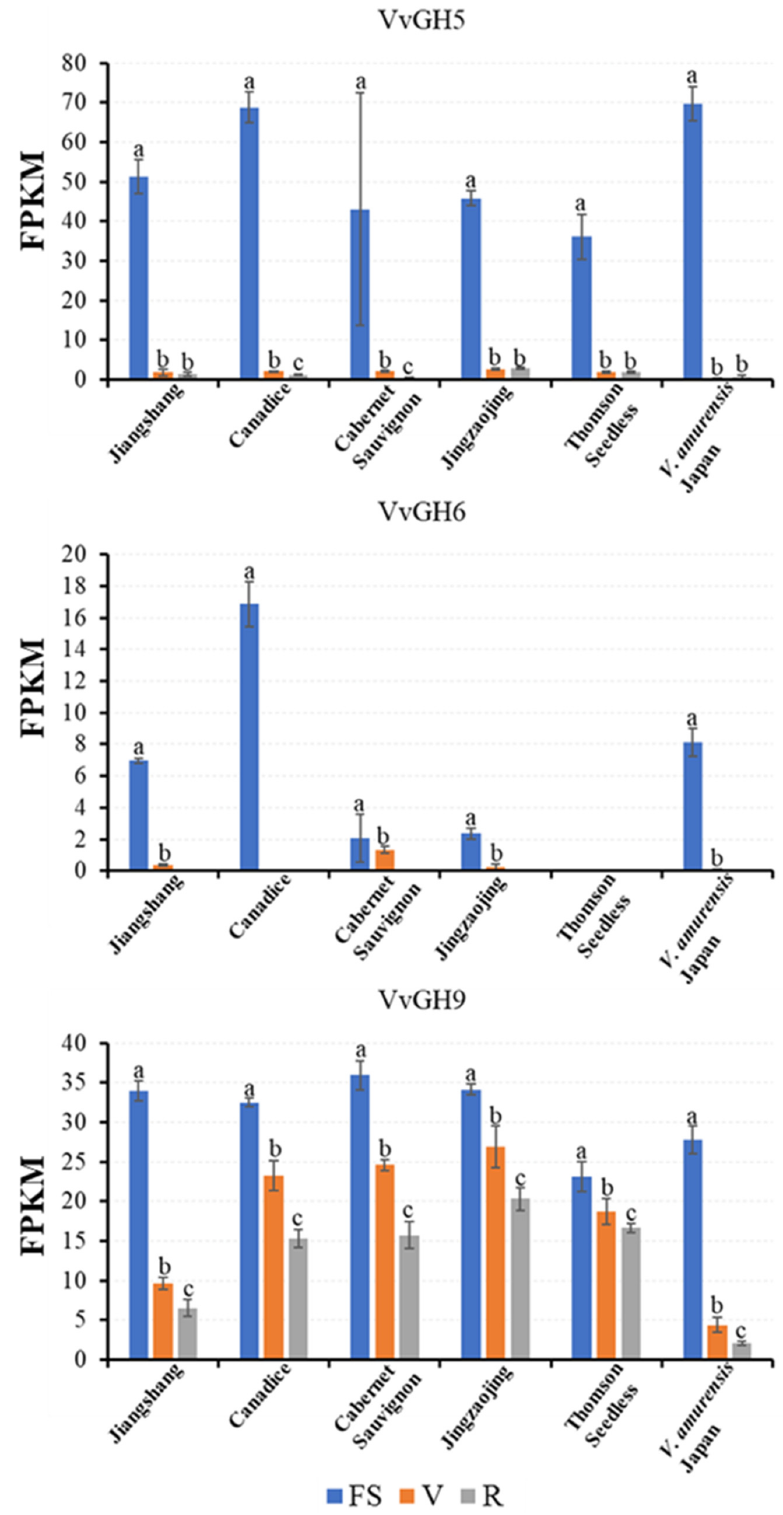
Figure 4. Transcriptomics analysis of VvGH5 , VvGH6 , and VvGH9 at three developmental stages of six representative grape varieties berry. The expression levels of the three genes were downloaded from the grape-RNA database. FS: fruit set; V: véraison; R: ripe. The letters above the bars indicated the significant differences by student’s t -test ( p < 0.05). Three biological replicates were analyzed, and the error bars represented the SD.